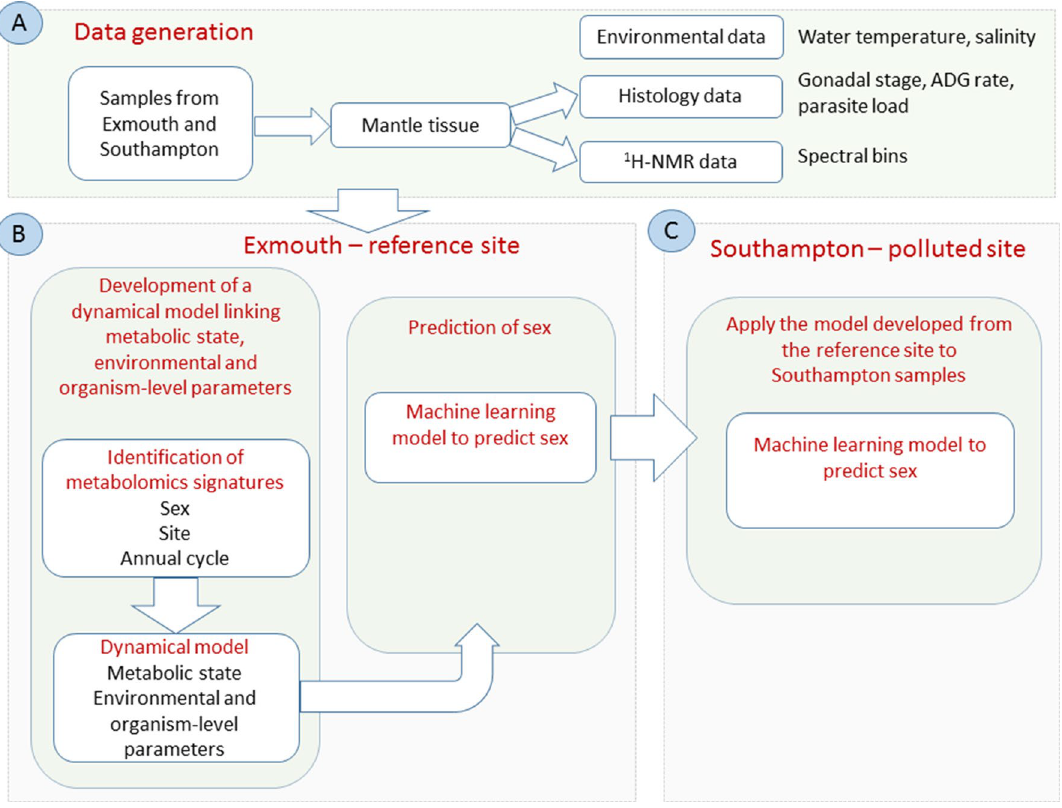
Figure 1. Overview of the data analysis